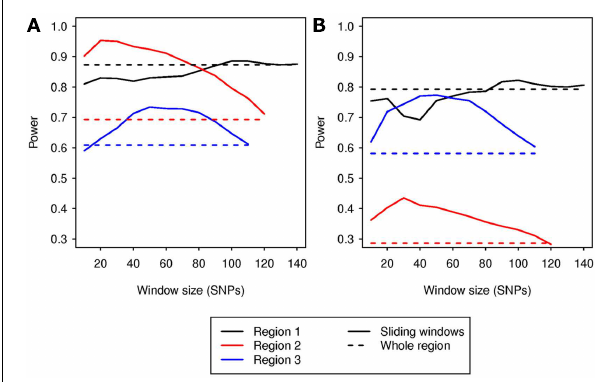
Positive values (bold) indicate increased power when protective variants are added to the simulations.